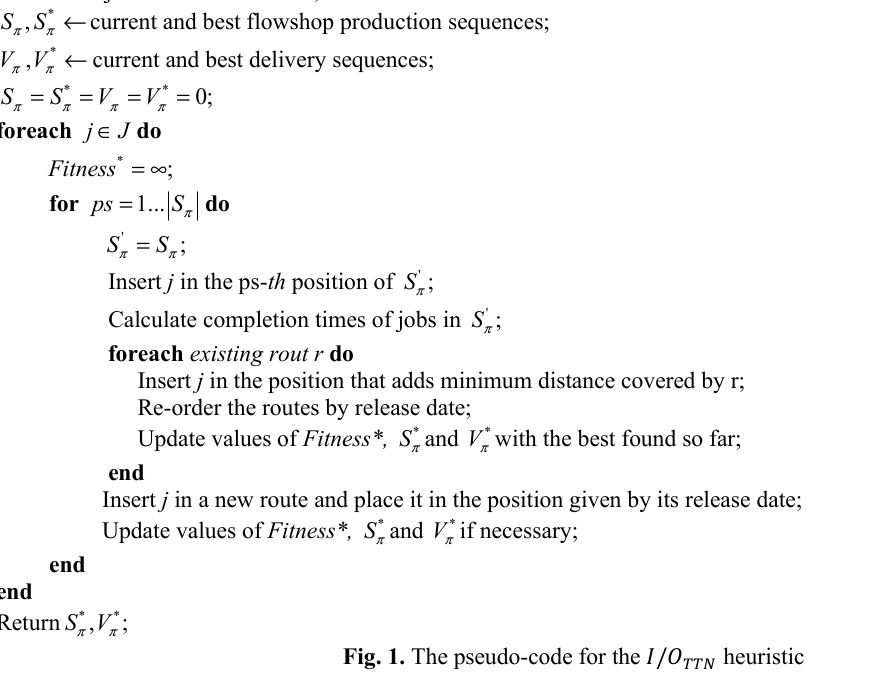
(cid:3021)(cid:3021)(cid:3015)